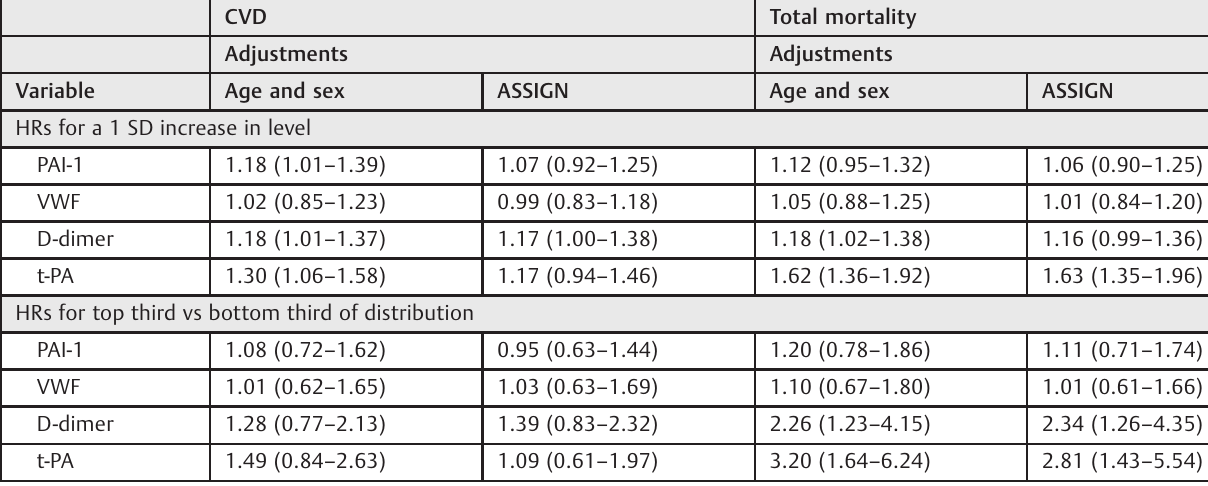
Table 2 Associations with outcomes: 1989 MONICA survey